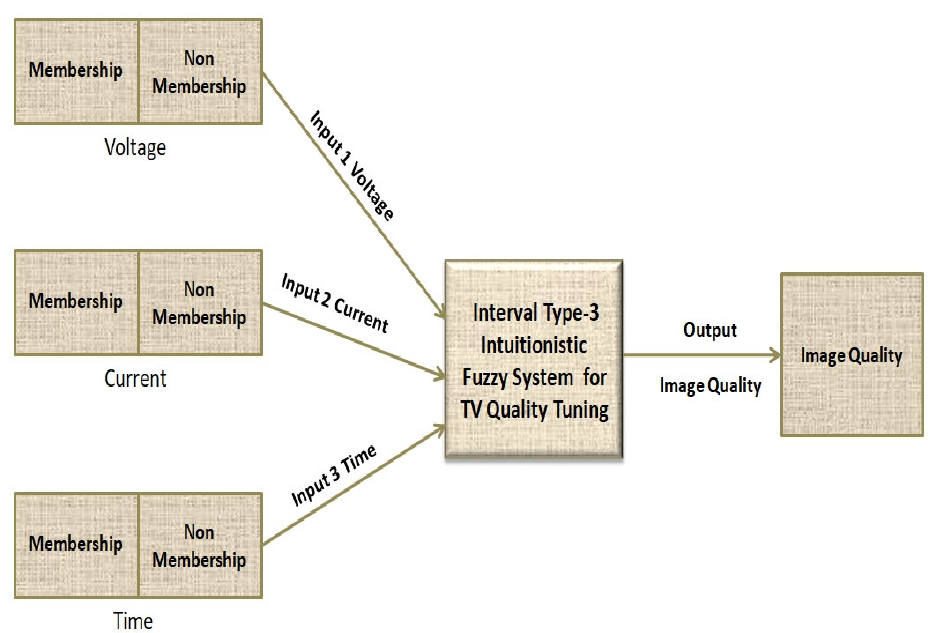
Figure 3. Architecture of the interval Type-3 intuitionistic system.